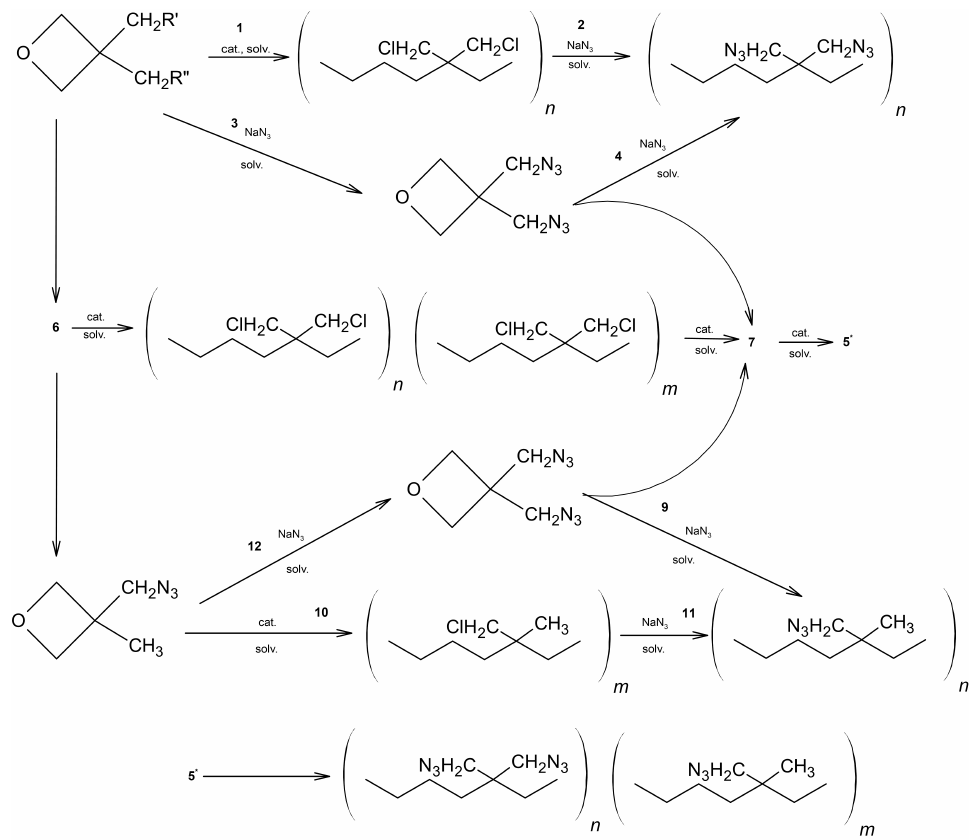
Figure 5. An important aspect during polymerisation was the maintenance of appropriate conditions. The reactions should be carried out without oxygen and moisture, and only pure monomers should be used. The reactions were carried out in methylene chloride, in the argon atmospheres. The monomer concentrations used were in the range were 2.0–2.5 M.